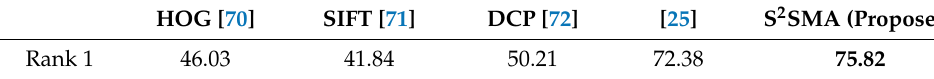
Table 14. Accuracy (%) comparisons by different methods on